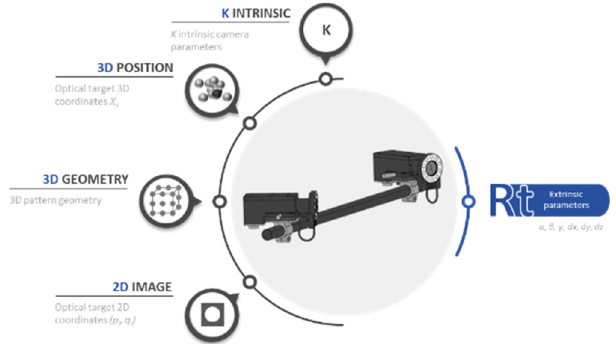
Figure 8. The factors that affect the correct determination of the intrinsic parameters are the 3D position, 3D geometry, 2D image and the K intrinsic